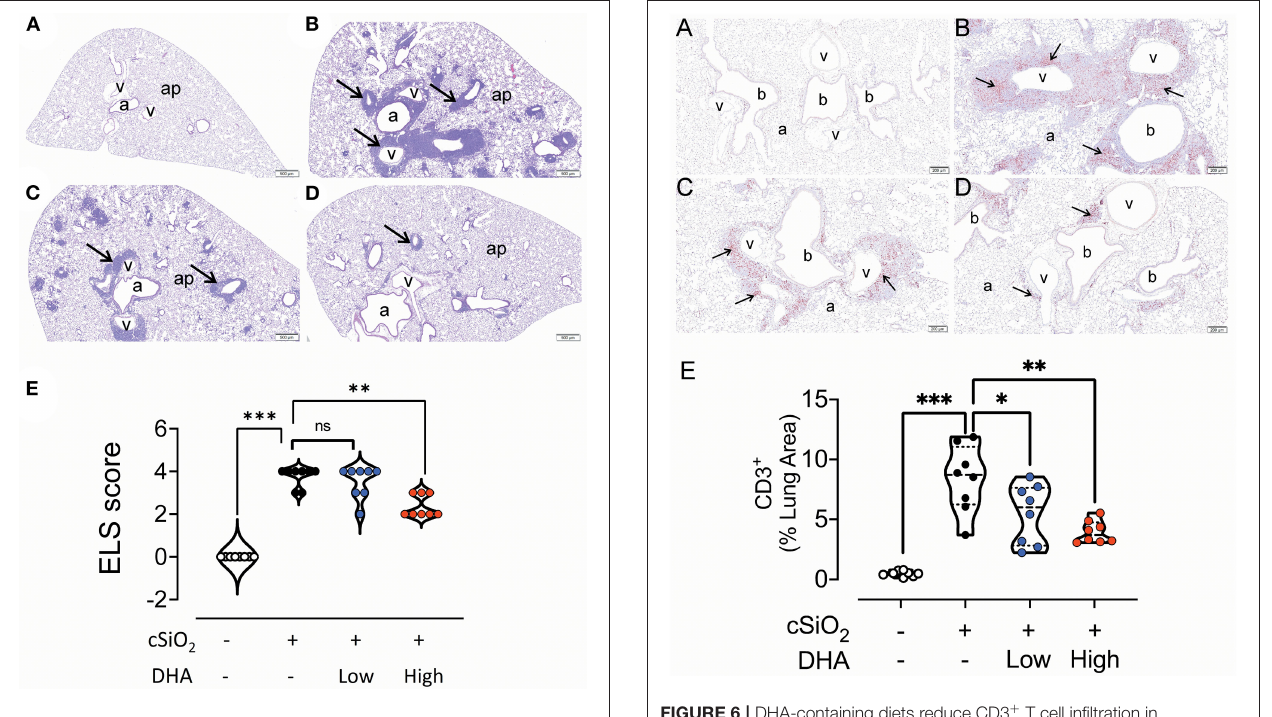
FIGURE 5 | High DHA diet reduces perivascular and peribronchiolar lymphoid aggregates in the lungs of cSiO 2 -treated mice. Light photomicrographs of hematoxylin and eosin-stained lung tissue sections (A–D) from mice fed control diet and intranasally instilled with saline vehicle (Veh/CON, A ), fed control diet and intranasally instilled with cSiO 2 (cSiO 2 /CON, B ), fed 0.4 % DHA diet starting one week after the end of the intranasal cSiO 2 instillations (cSiO 2 /low DHA, C ), or fed the 1.0% DHA diet starting one week after the end of the intranasal cSiO 2 instillations (cSiO 2 /high DHA, D ). Marked perivascular and peribronchiolar airway lymphoid cell accumulation (ectopic lymphoid structures [ELS]; arrows) observed in the lung of cSiO 2 /CON mouse that did not receive DHA treatment (B) . Slightly less severe ELS formation around vessels and airways in the lung of cSiO 2 /low DHA mouse (C) . Only minimal perivascular and peribronchiolar lymphoid aggregates in the lung of cSiO 2 /high DHA mice (D) . b, bronchiolar airway; v, blood vessel, a, alveolar parenchyma. (E) Individual sections were semi-quantitatively scored for ELS using the following criteria: (0) no changes compared to control mice; (1) minimal ( < 10%); (2) slight (10–25%); (3) moderate (26–50%); (4) severe (51–75%); or (5) very severe ( > 75%) of total area affected. Horizontal lines represent mean ± SEM. Statistical comparisons were performed as described in the Methods section. *** p ≤ 0.001, ** p ≤ 0.01, ns = not significant.